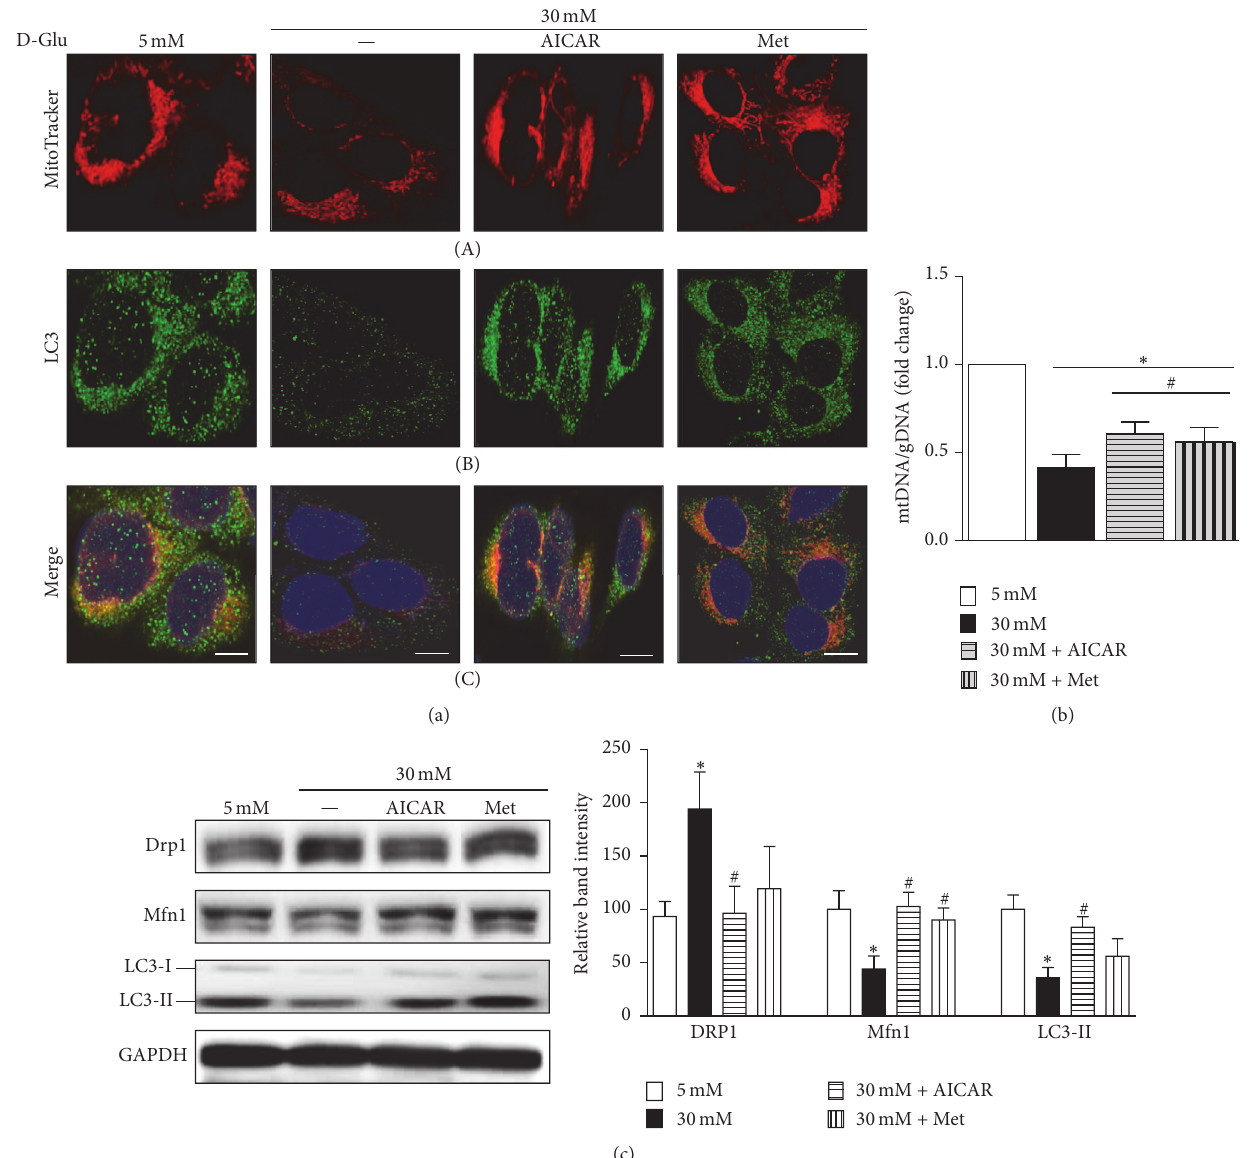
Figure 4: AICAR and metformin ameliorate the effect of high-glucose (HG) concentrations on mitochondrial dynamics and autophagy in human renal proximal tubular cells (RPTCs). (a, A, B, and C) Representative confocal fluorescence images of MitoTracker and LC3 show an increase in functional mitochondria and autophagic activity after exposure to HG and treatment with AICAR or metformin in human RPTCs. (b) Increased mtDNA to gDNA ratio was observed in human RPTCs treated with metformin or AICAR in the presence of HG. (c) Western blot analyses showed the reversal of alterations in the expression levels of profission (Drp1), profusion (Mfn1), and autophagy-related proteins (LC3-II) in the presence of HG after treatment with AICAR or metformin. ( ∗ 𝑝 < 0.05 versus 5mM glucose; # 𝑝 < 0.05 versus 30mM glucose; scale bar 5 𝜇